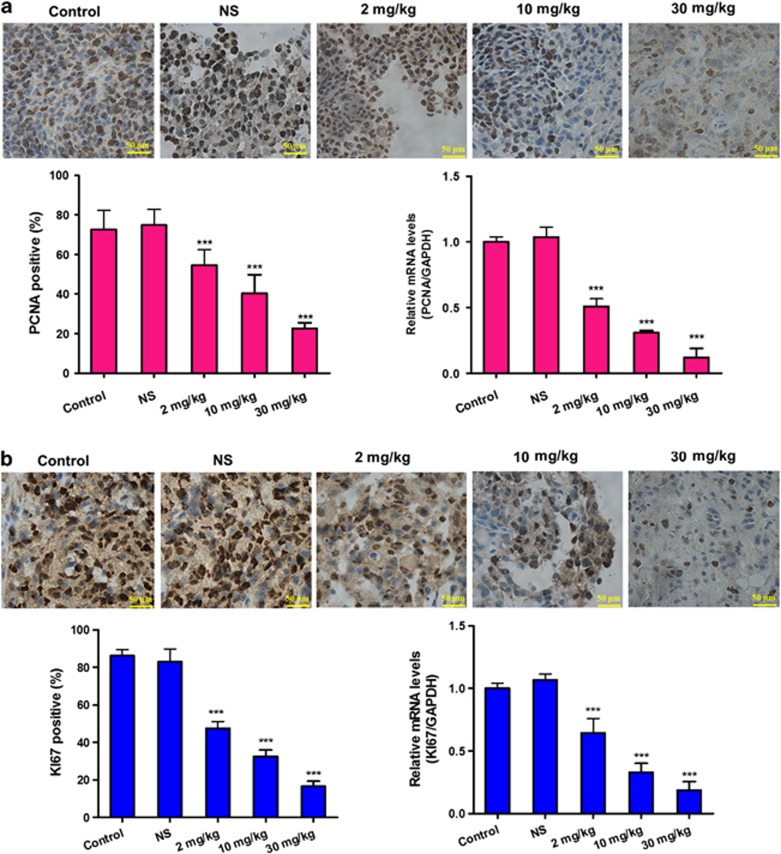
The effect of mogroside V on the expression of PCNA and Ki-67 in PANC-1 xenograft tumors. (a) Images of immunohistochemical staining and RT–PCR analysis indicating that mogroside V inhibits PCNA expression. (b) Images of immunohistochemical staining and RT–PCR analysis indicating that mogroside V inhibited PCNA expression. The data represent the means±s.d. Statistical analysis was performed using the Student's t-test; ***P<0.001 versus the control values.